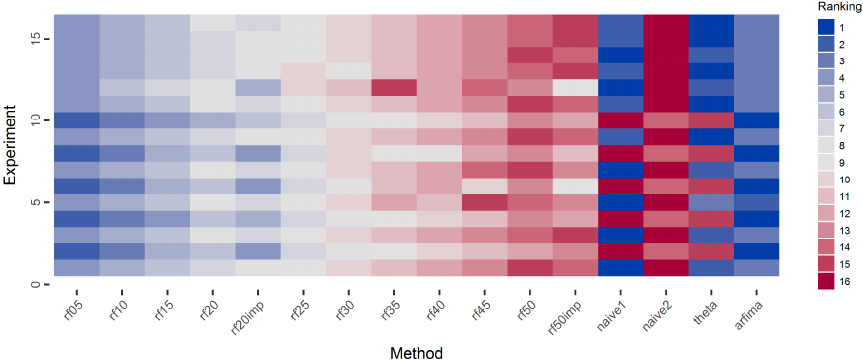
Figure 12. Ranking of methods in each simulation experiment based on the regression coefficients. Better methods are presented with lower ranking value and blue colours.